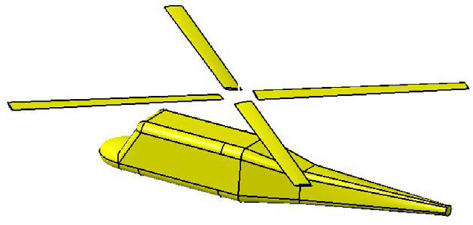
Figure 3. Helicopter model with HUEY fuselage.